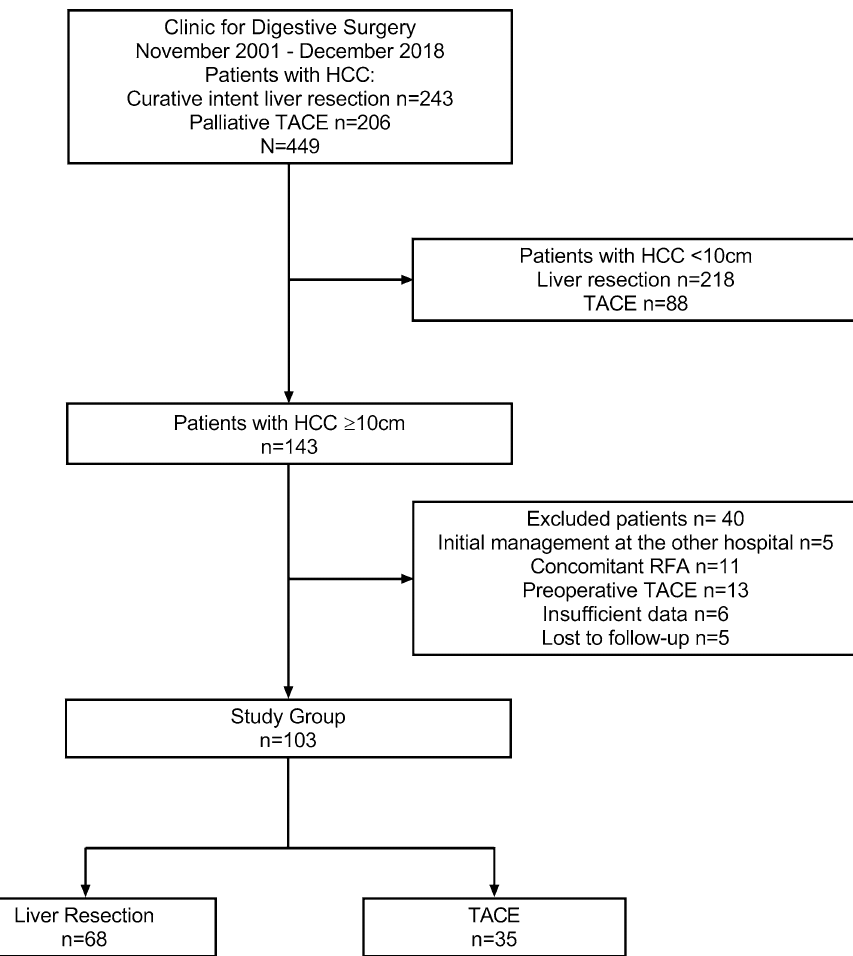
Figure 1. Study flow diagram. HCC hepatocellular carcinoma, TACE transarterial chemoembolization, RFA radiofrequency